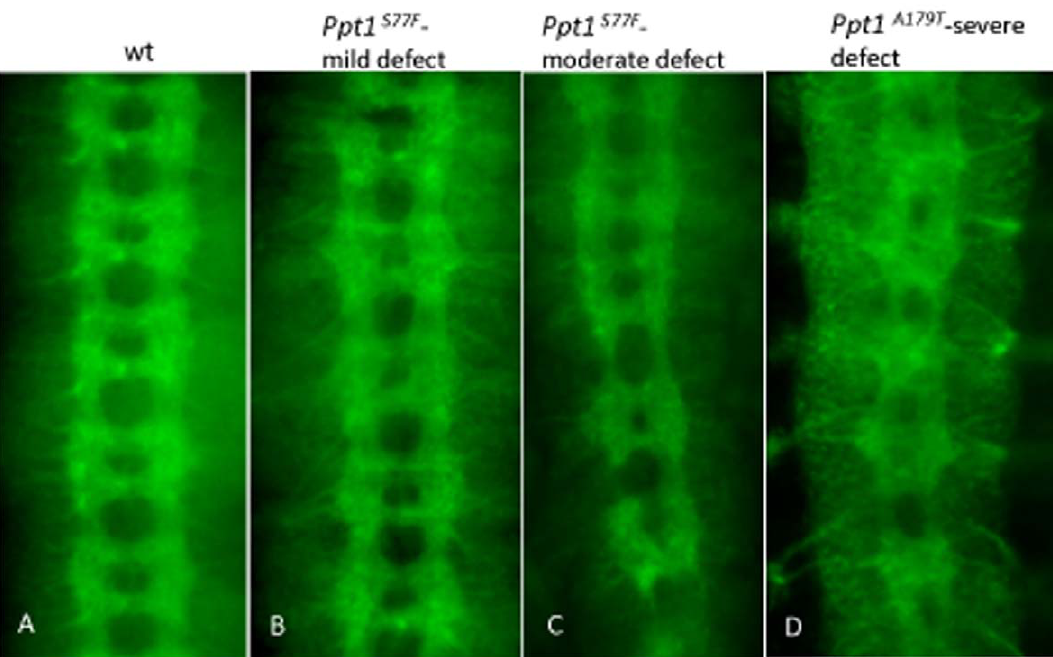
Figure 4. CNS scaffold abnormalities in Ppt1 mutant embryos. In all panels, S16 embryos were stained with BP102. (A) Wild type embryo. (B) Axon defects range from mild phenotypes such as irregularly spaced axon tracts in commissures and wavy, thinning longitudinal connectives; to more severe phenotype such as fused commissures and disorganized CNS tracts (C and D). Anterior, up.